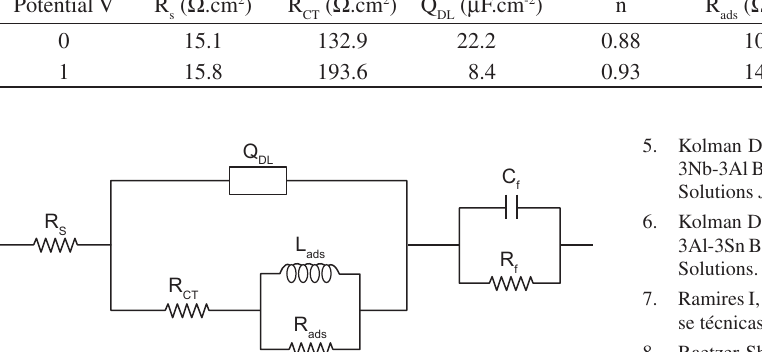
Figure 15. Equivalent circuit obtained from fitting and simulation of Nyquist plots in Figure 12.